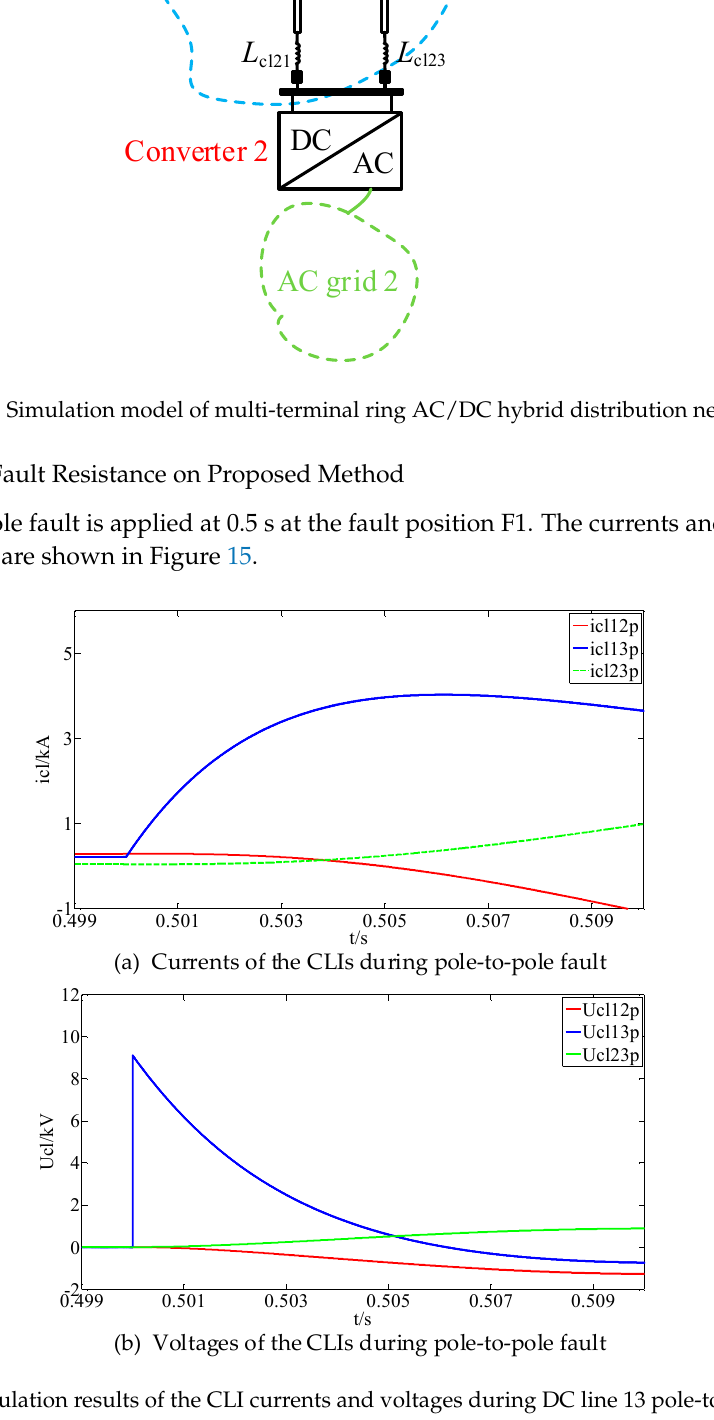
Figure 15. Simulation results of the CLI currents and voltages during DC line 13 pole-to-pole fault.